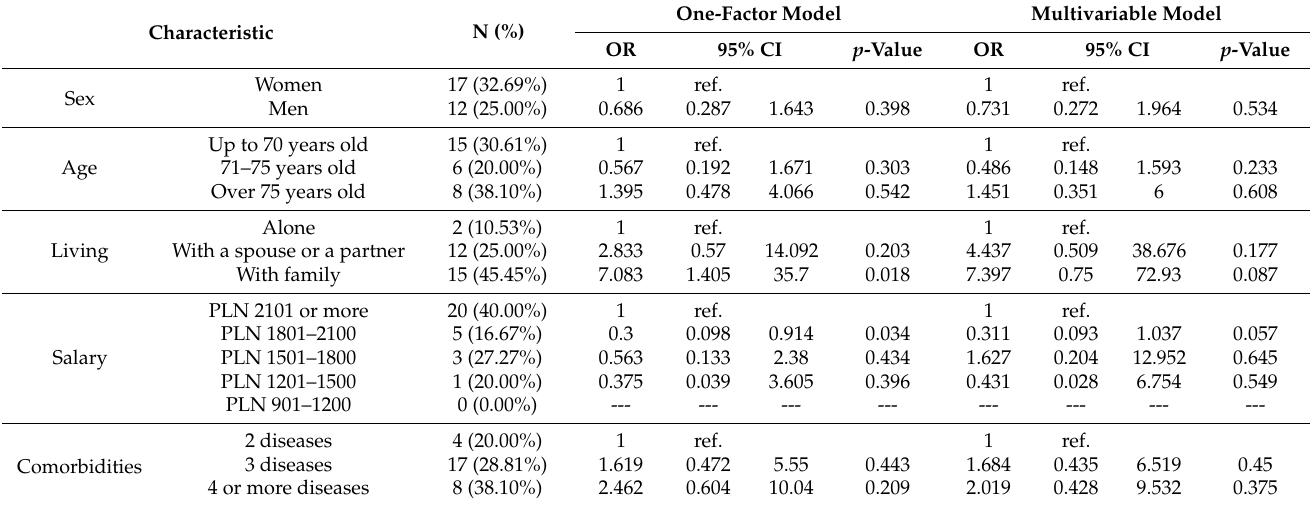
Table 7. Results of univariable and multivariable regression analysis—multimorbidity and